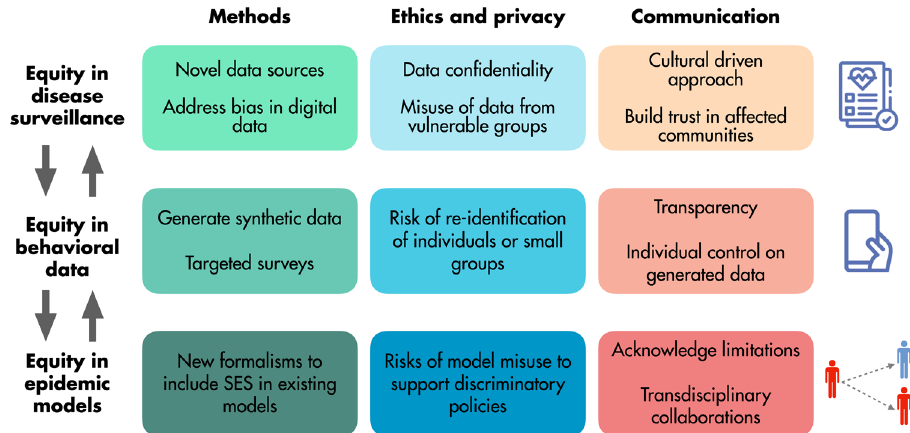
Fig. 1 Practical guidelines to introduce an equity lens into the computational modeling of infectious diseases and related challenges. The fi gure illustrates and summarizes key recommendations and associated challenges, grouped by area of relevance in the data-model framework of computational epidemiology: surveillance data, behavioral data, and epidemic models. SES